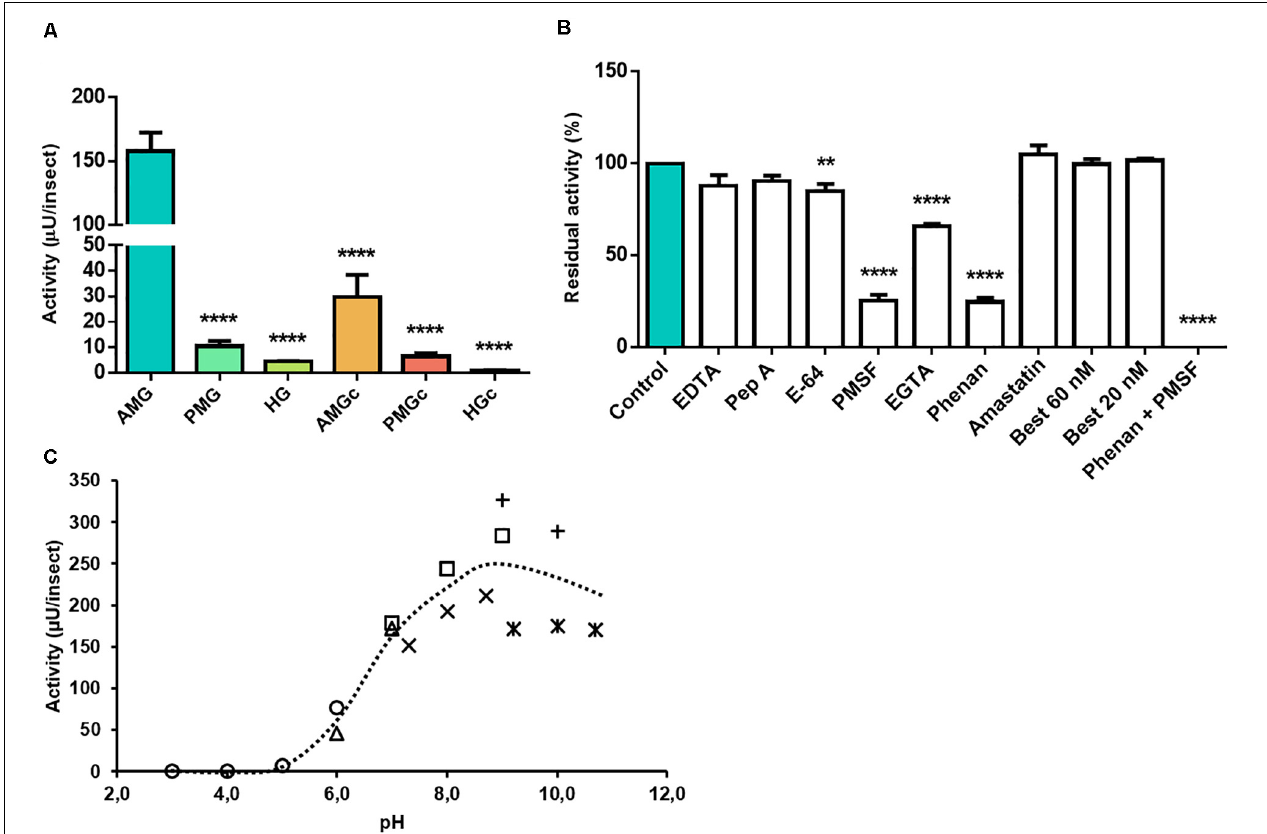
FIGURE 3 | Compartmentalization and characterization of aminopeptidase activity in the digestive tract compartments of male adult Rhodnius prolixus . (A) Comparison of protease activity between homogenates of the anterior midgut (AMG), posterior midgut (PMG), and hindgut (HG) tissues and their respective luminal contents, assayed in 0.2 M glycine-NaOH pH 9.0. (B) Effects of the protease inhibitors EDTA (10 mM), pepstatin A (1 µ M), E-64 (10 µ M), PMSF (1 mM), EGTA (10 mM), phenanthroline (10 mM), amastatin (10 µ M), bestatin (20 and 60 nM), and a combination of phenanthroline and PMSF, in their respective concentrations, on the proteolytic activity of AMG tissues, assayed in 0.2 M glycine-NaOH pH 9.0. (C) Effects of pH variation on the proteolytic activity of AMG tissue homogenate, using the buffers citrate-phosphate pH 3.0, 4.0, 5.0, and 6.0 ( ); MES, pH 6.0 and 7.0 ( (cid:49) ); EPPS, pH 7.3, 8.0, and 8.7 ( × ); Tris-HCl, pH 7.0, 8.0, and 9.0 ( (cid:3) ); glycine-NaOH, pH 9.0 and 10.0 (+); and carbonate/bicarbonate 9.2, 10.0, and 10.7 (*). Bars and markers are means of at least nine biological replicates (cid:35) with the standard error of the mean (SEM). Asterisks denote statistically significant differences, ** p ≤ 0.01 and **** p ≤